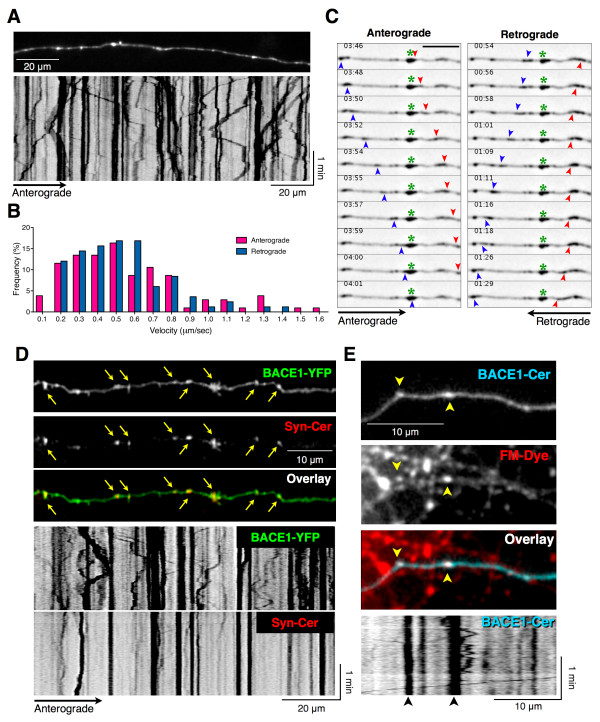
Characterization of dynamic BACE1 axonal transport and localization in functional synapses in cultured hippocampal neurons. (A-C) Axonal transport of BACE1-YFP. (A) Time-lapse images of transfected neurons (DIV12-13) were acquired at the rate of 1 frame/sec for 3–5 min. A representative frame and the kymograph of the image series corresponding to Additional file 2 are shown. (B) Maximum velocities of vesicles moving away (anterograde, n = 106) or toward (retrograde, n = 83) the cell body were quantified from kymographs of multiple axons imaged from five independent cultures and plotted. (C) Representative image montages of time-lapse sequences from a segment of the axon shown in Additional file 2 depict dynamic transport of BACE1-containing vesicles and tubulo-vesicular structures. Vesicles containing BACE1-YFP are transported in the anterograde (left panels) or the retrograde (right panels); several BACE1-positive structures also remain stationary (indicated by a green asterisks). Note the anterograde BACE1-containing vesicles emerging from the stationary larger vesicular structure. (D) Presynaptic localization of BACE1 in cultured hippocampal neurons. Live-cell images from a transfected neuron (DIV14) show colocalization of BACE1-YFP with synaptophysin-Cerulean. Sequential time-lapse images were acquired on the same axon (Additional file 3), and the dynamics of BACE1 and synaptophysin were analyzed by generating kymographs. Note that the large, stationary, BACE1-containing pleomorphic structures are positive for synaptophysin. (E) Localization of BACE1-Cerulean (BACE1-Cer) in functional synapses of DIV13 neurons labeled with FM1-43 (arrowheads). A kymograph of BACE1-Cer dynamics in the same axonal segment is shown in the bottom panel. Note that BACE1-Cer remains stationary (arrowheads) in structures that overlap with FM1-43 labeled synapses.